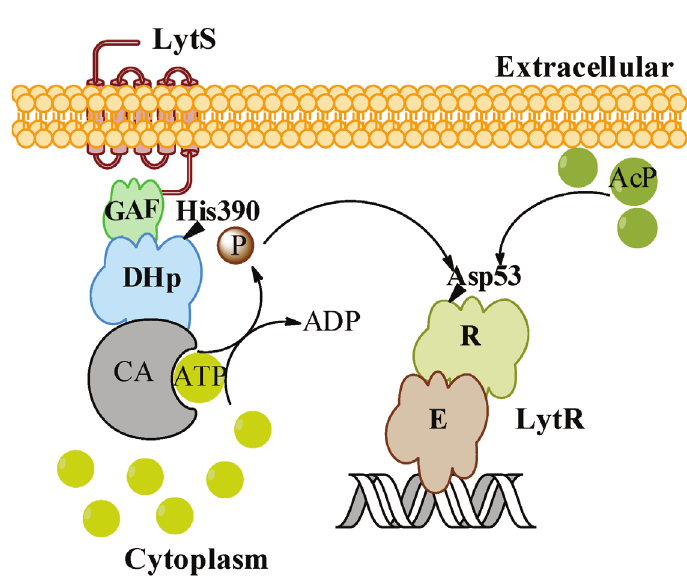
Figure 7. The schematic illustration of the signal transduction by LytSR. Our data support two pathways of activation of LytR: through LytS as a result of perturbation of the membrane electric potential, and through acetyl phosphate as a result of accumulation of acetate during metabolism of excess